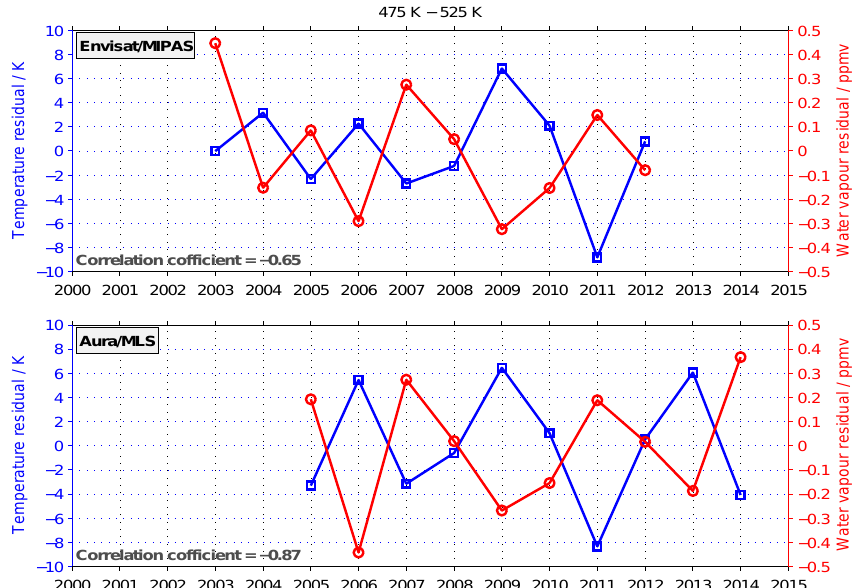
Figure 14. Correlation of temperature (blue) and water vapour (red) anomaly derived from Envisat/MIPAS (top) and Aura/MLS (bottom) for potential temperature range 475–525K (3month average consisting of the months January, February and March; MIPAS: 2002–2012, MLS: